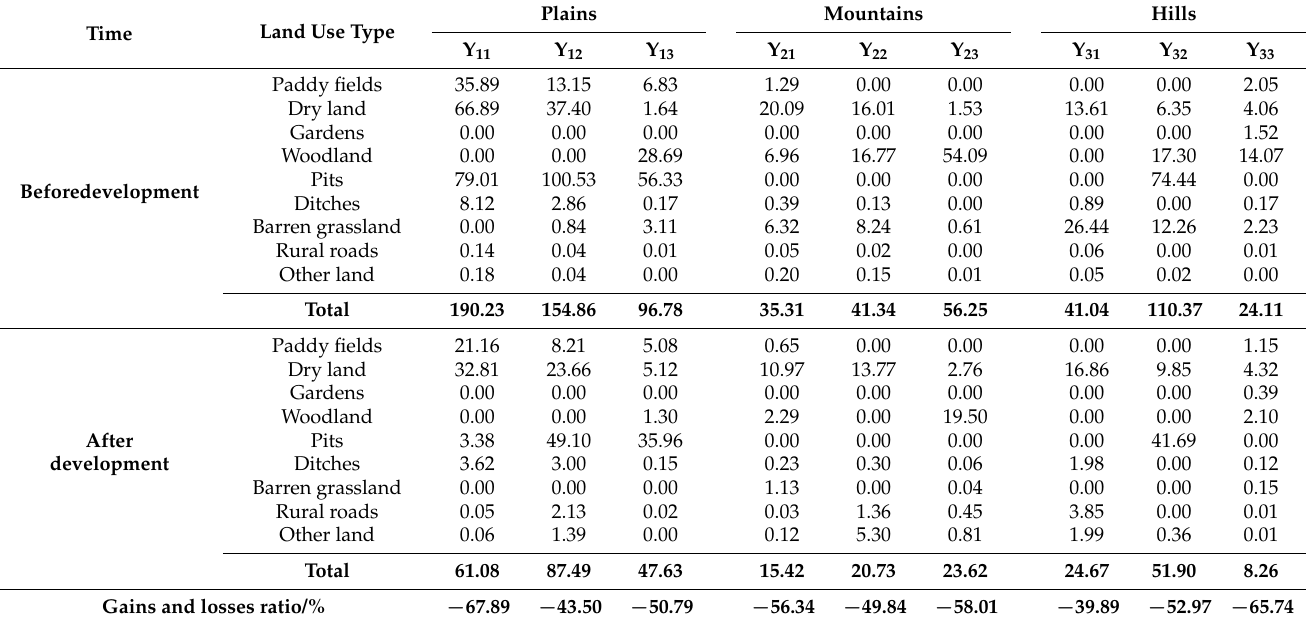
Table 4. Changes in the total amount of ESV before and after development. Unit: × 10 5